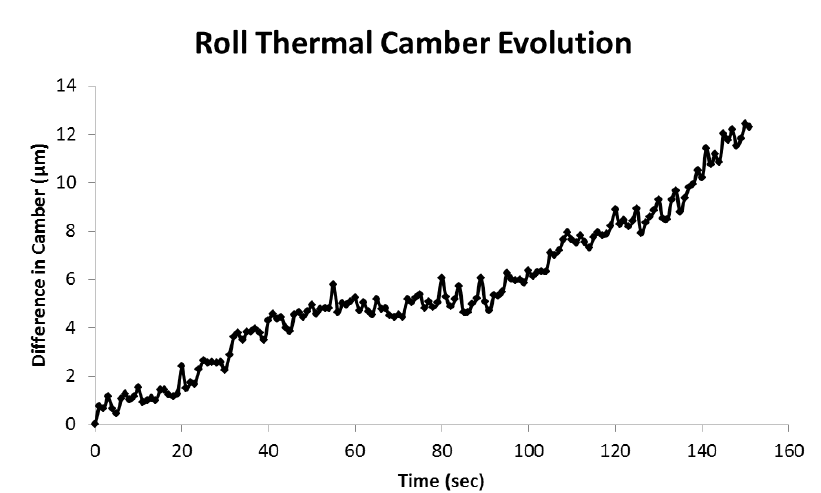
Figure 4. Calculated roll thermal camber evolution for the validation pass.